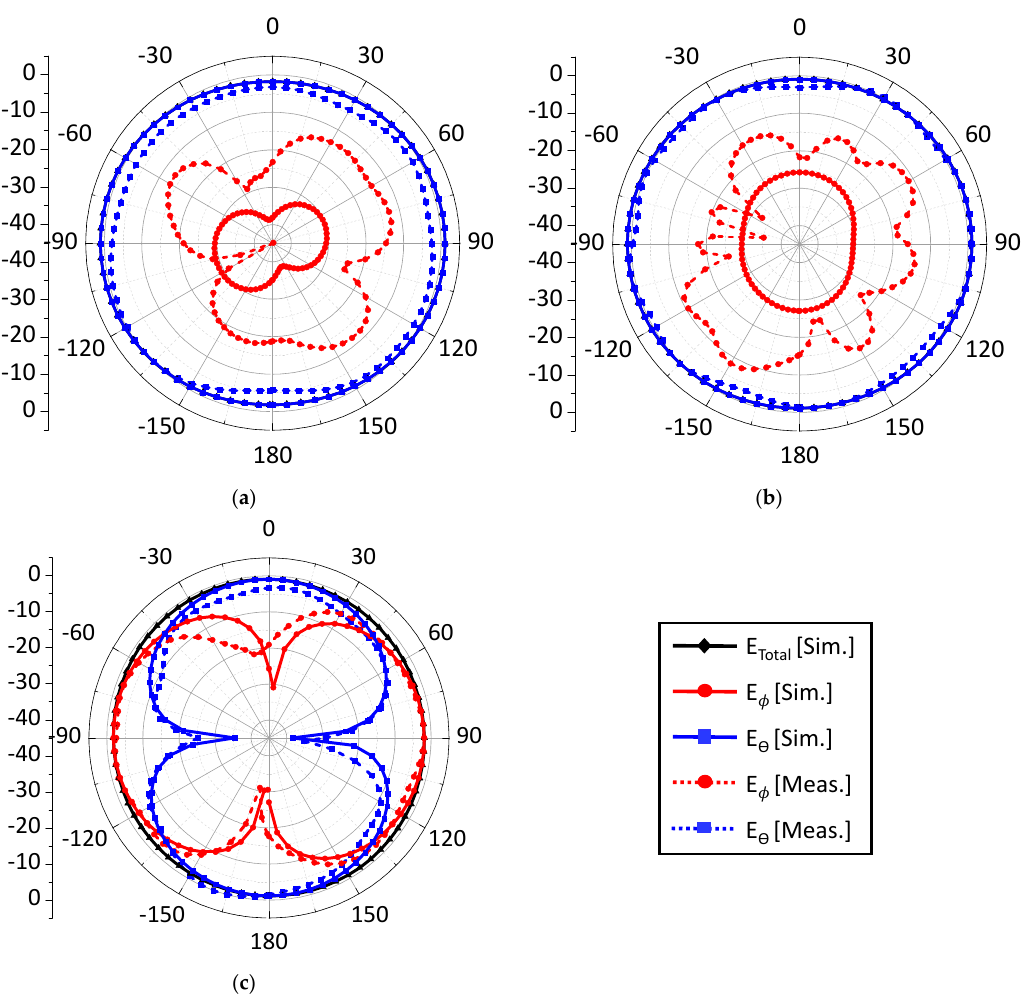
Figure 9. Simulation and measurement radiation pattern of the proposed antenna: ( a ) xy, ( b ) yz, and ( c ) xz planes.